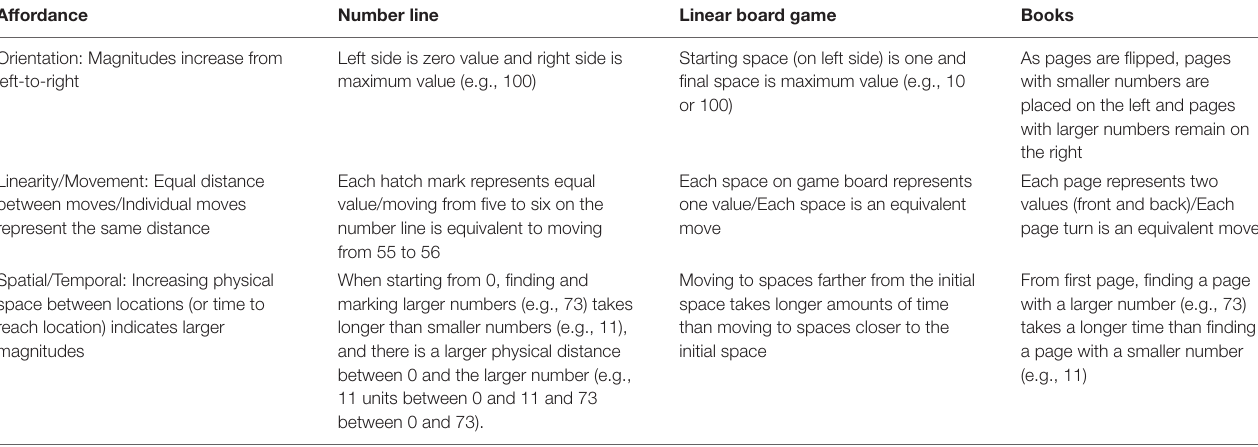
TABLE 1 | Comparison of magnitude affordances across